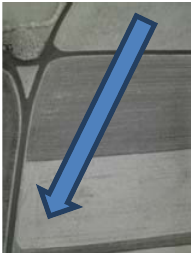
Figure 16: NIR-Orthomosaic image patch with field of red clover (arrow) (Source: Flight and AT GerMAP GmbH, Orthomosaic Pieneering OY).